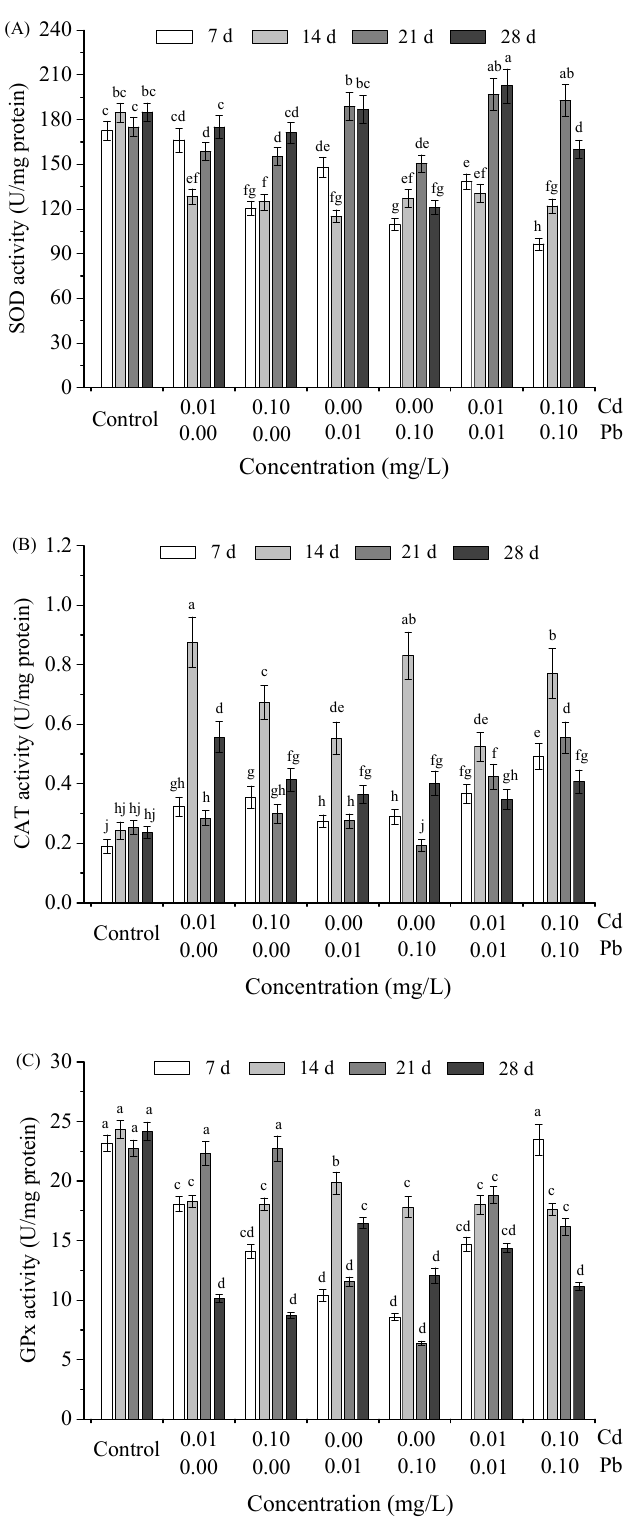
Figure 2. Changes of antioxidant enzyme activities including SOD ( A ); CAT ( B ); and GPx ( C ) in the hepatopancreas of M. nipponense following various treatments with single Cd, Pb and their mixture along increasing concentrations (0.01 and 0.10 mg/L) at four time points (7, 14, 21 and 28 days). Different letters indicate a significant difference among groups (ANOVA, p < 0.05), while the same letters indicated no significant difference (ANOVA, p < 0.05). Control represents the water without Cd and Pb.